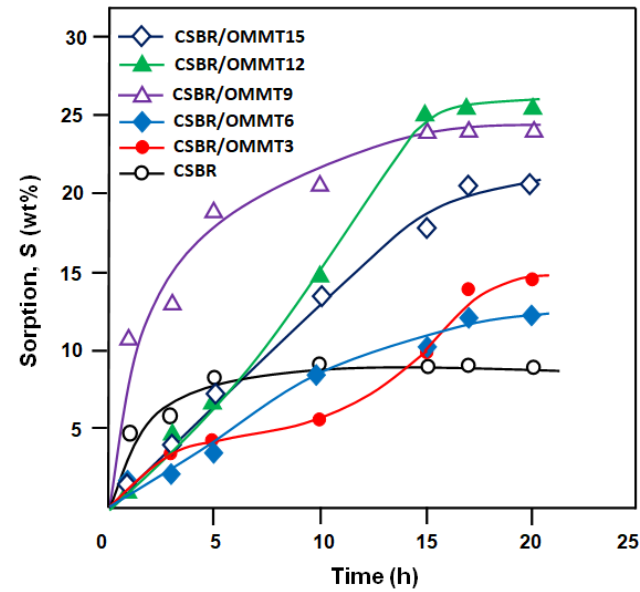
Figure 9. Variation of swelling degree of CSBR and CSBR/OMMT membranes with different OMMT contents versus time in methanol.